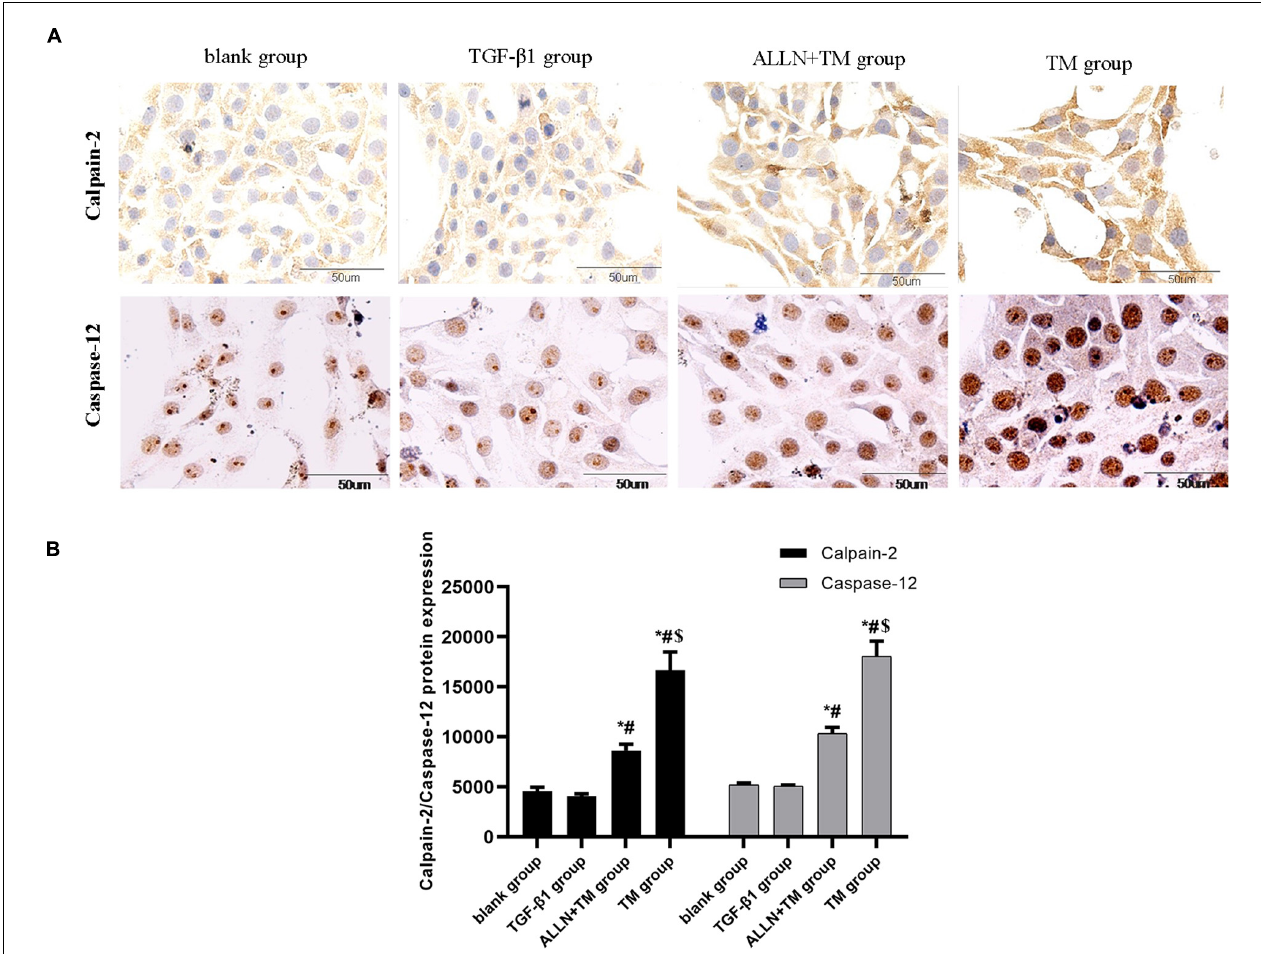
FIGURE 6 | The protein expression level of calpain-2 and caspase-12 in HSC in different groups. Expressions of calpain-2 and caspase-12 protein were detected by immunocytochemistry. (A) Brown part in the figures represent the protein expression in HSC. (B) Columns represent protein expression level of calpain-2 and caspase-12 in HSC (* p < 0.05 compared with the blank group; # p < 0.05 compared with the TGF- β 1 group; $ p < 0.05 compared with the ALLN + TM